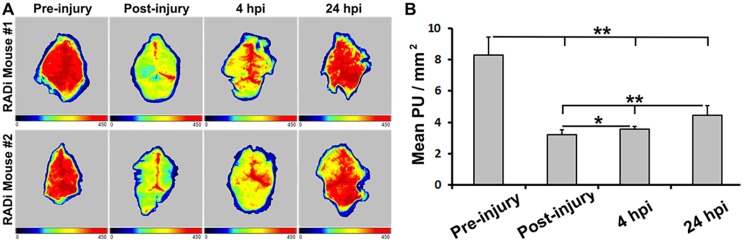
Cerebral blood perfusion preinjury, immediately after RADi, and 4 h and 24 h following 60 psi×60 RADi. (A) Representative images of LASCA of blood perfusion in two RADi mouse brains. Baseline and RADi images show areas of yellow-red as high blood perfusion and areas of blue-black as low blood perfusion. (B) Statistical analysis of mean PU per square millimeter. Data are presented as mean±s.d. and were analyzed by one-way with repeated-measures ANOVA followed by Tukey's post hoc test. *P<0.05, **P<0.01; n=6.